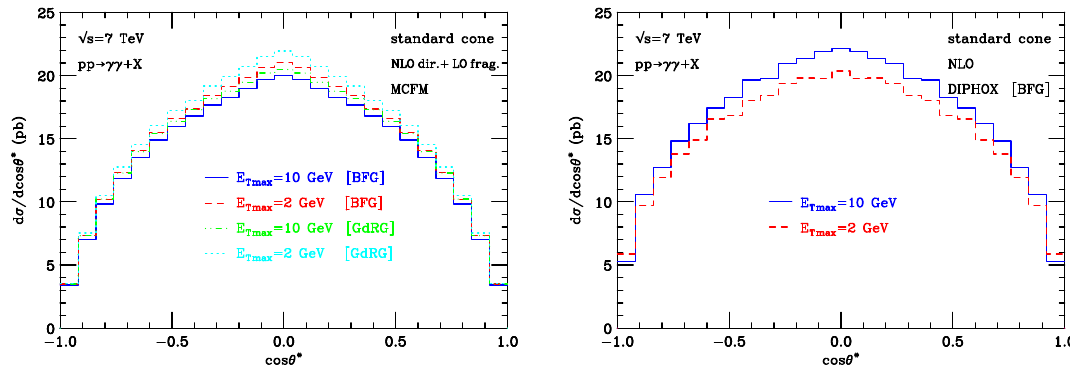
Figure 9 . The cos θ ∗ differential cross section for standard cone isolation with two different values of E T max (2 GeV and 10 GeV) and the same photon kinematical cuts as in figure 4. The QCD results are obtained at the central value of the scales ( µ F = µ R = µ frag = µ 0 NLO direct + LO fragmentation components (left panel) use BFG and GdRG LO fragmentation functions. The NLO results (right panel) use BFG fragmentation